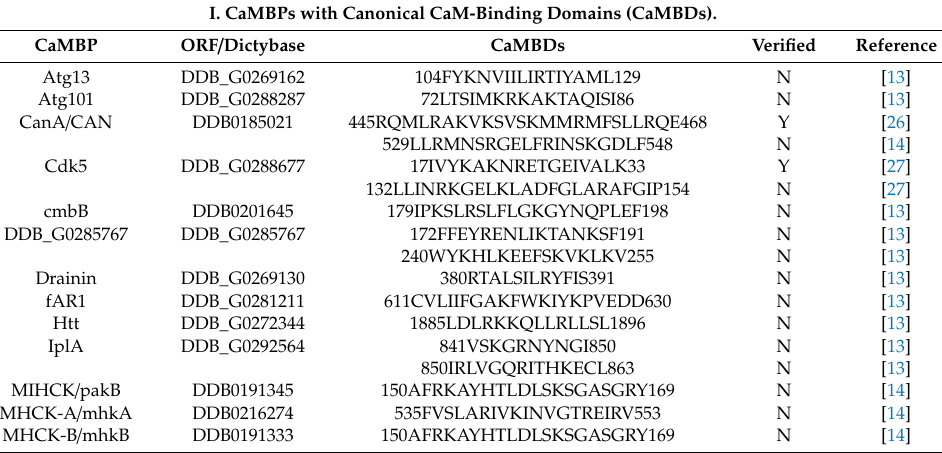
Table 1. Calcium-dependent CaM-binding domains of Dictyostelium